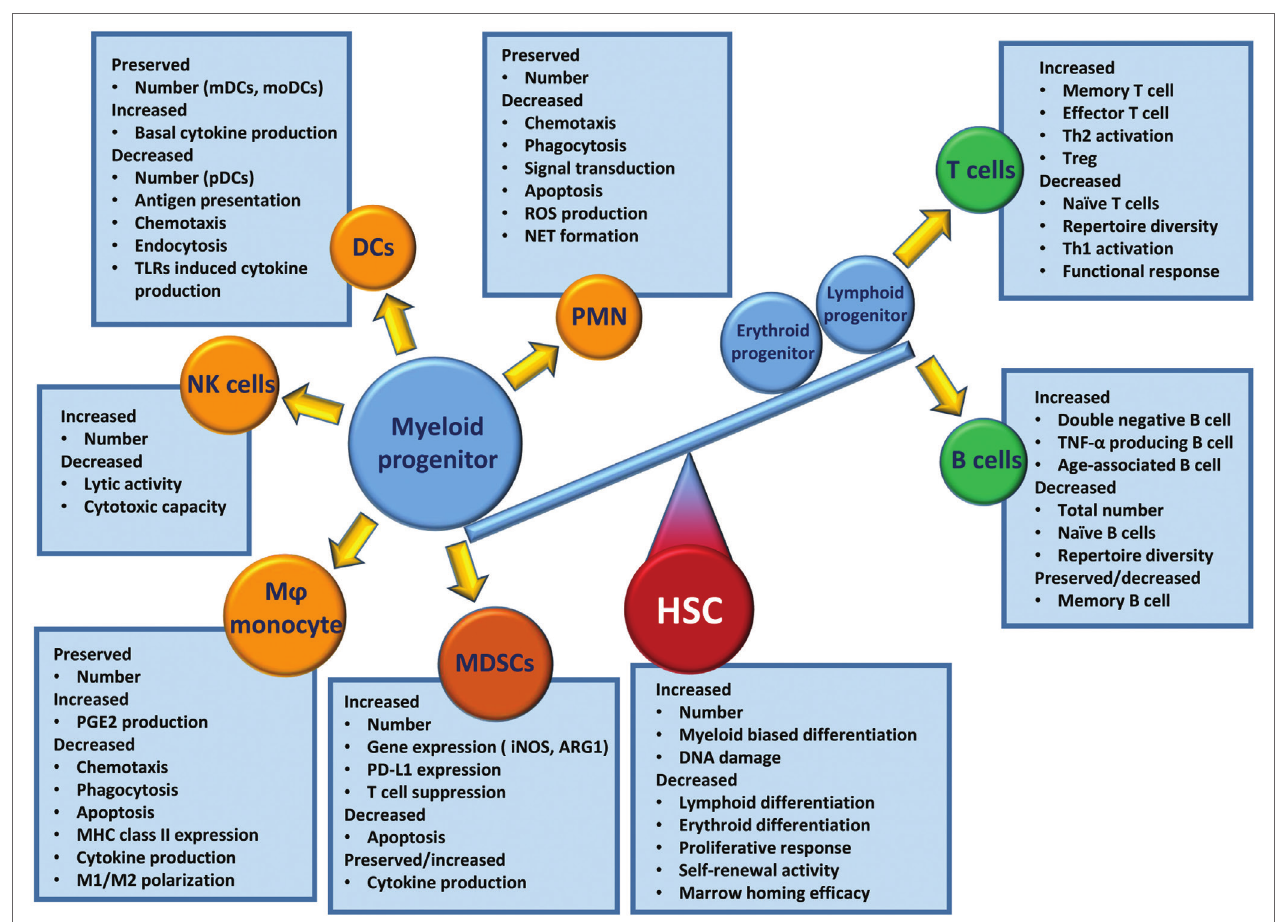
FiGURe 3 | Immunosenescence in hematopoietic stem cells (HSCs), innate, and adaptive immune